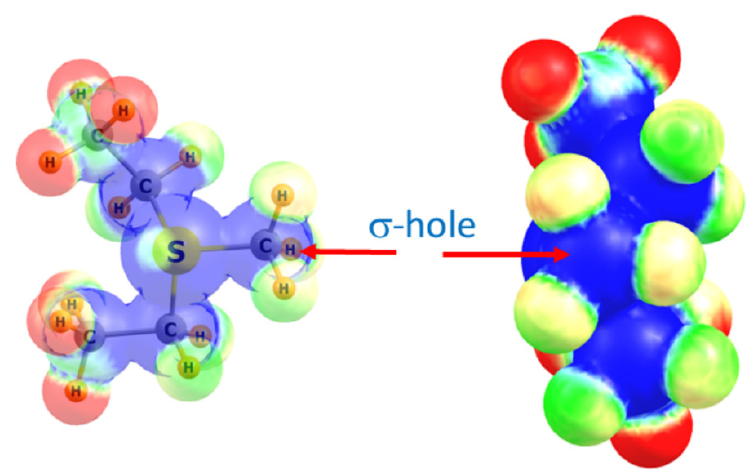
Figure 2. Two views of the molecular electrostatic potential surrounding the MeS + (Et) 2 sulfonium cation. Right view looks directly down the H 3 C–S axis. Blue and red colors correspond respectively to +0.40 and +0.30 au.